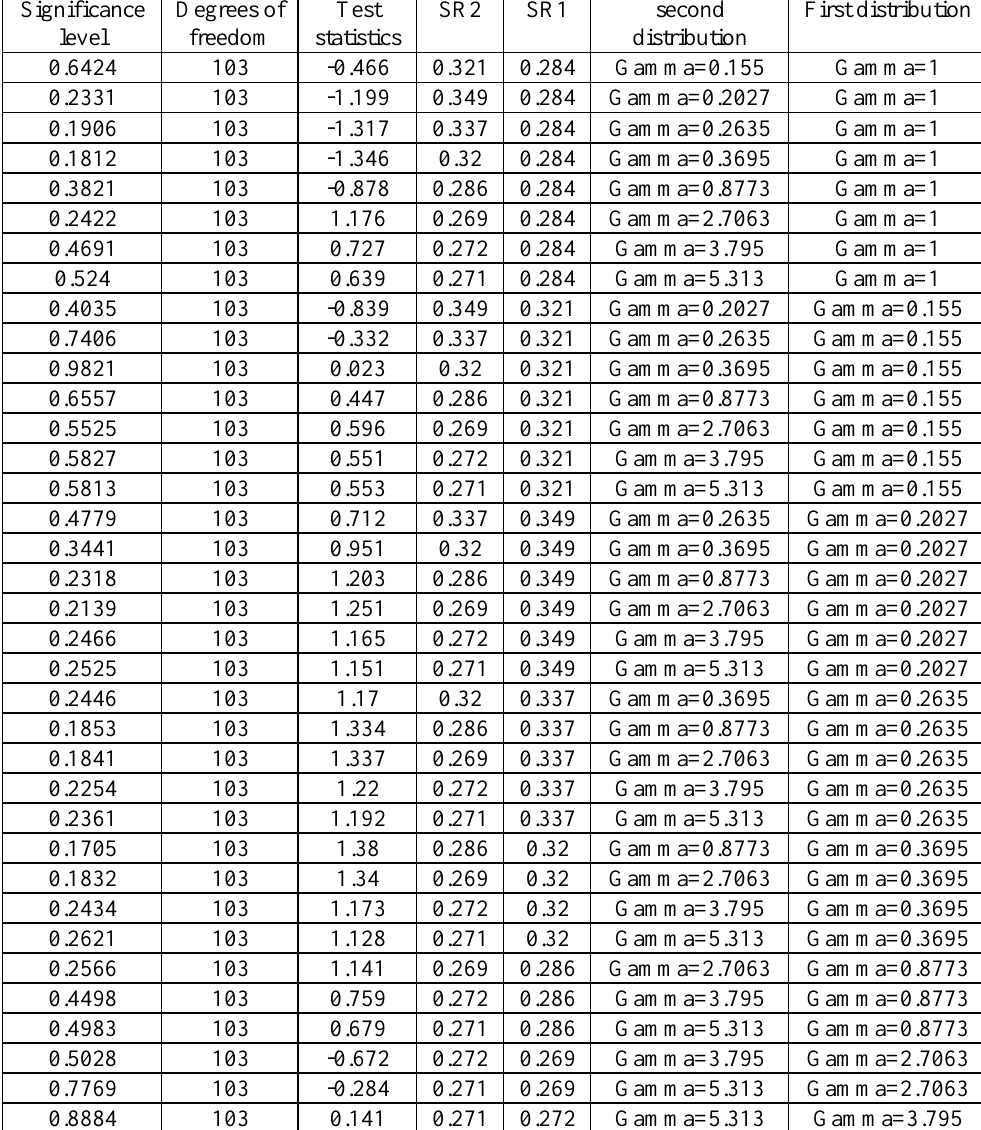
Table 1. Sharp parity test to compare portfolio performance (research